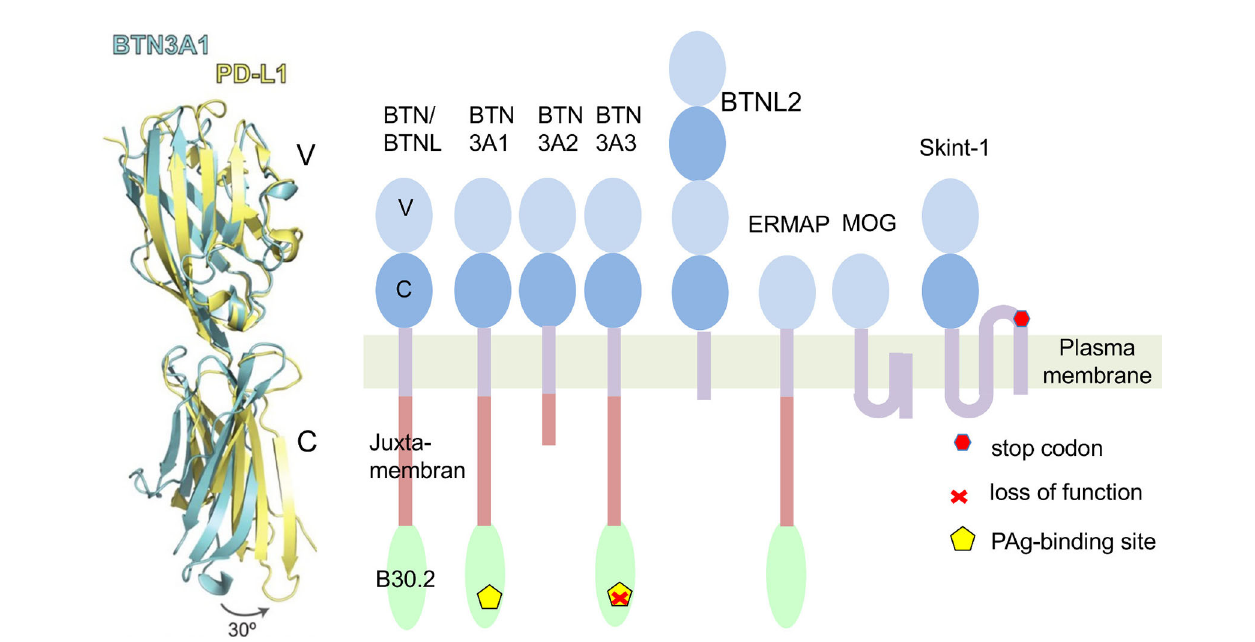
FIGURE 1 | Butyrophilins as members of the B7 family. Left: A comparison of structures of extracellular domains of programmed death ligand 1 (PD-L1: yellow) and Butyrophilin 3A1 (BTN3A1: blue). Shown is an overlay of the tertiary structure of both proteins. Differences of the C-domains of both molecules result mainly from a twist in the orientation of V- and C-Ig domains. In an exclusive overlay of V domain alone, similarities in the Ig-V domains would be even more pronounced. Picture is modi fi ed from (3). Right: Schematic representation of human BTN/BTNL family members and mouse Skint1. The protein domains are exempli fi ed for BTN3A1. ERMAP (Erythroblast membrane-associated protein), MOG (Myelin-Oligodendrocyte glycoprotein). Skint 1 (Selection and upkeep of intraepithelial T-cells 1). The indicated Stop codon inactivates the Skint1 function in the DETC de fi cient FVB/N-Tac mouse strain